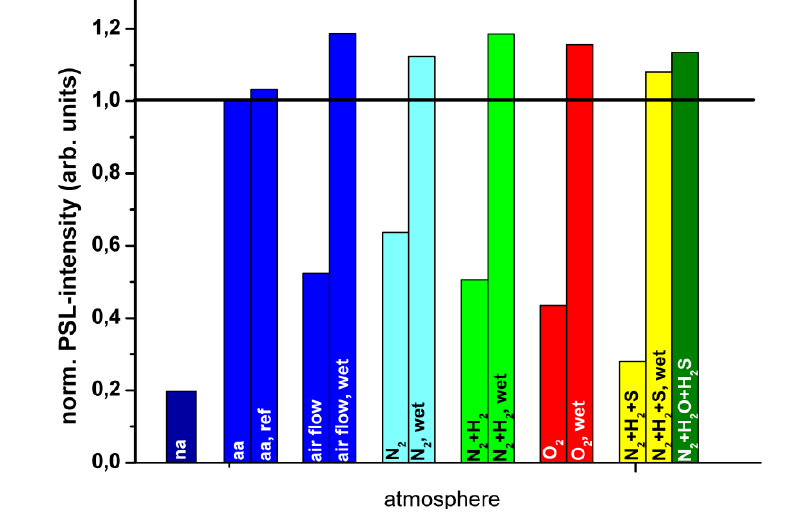
Figure 25. PSL enhancement following annealing at 170 °C for 4 hours in different atmospheres [84] (reproduced with permission from Martina